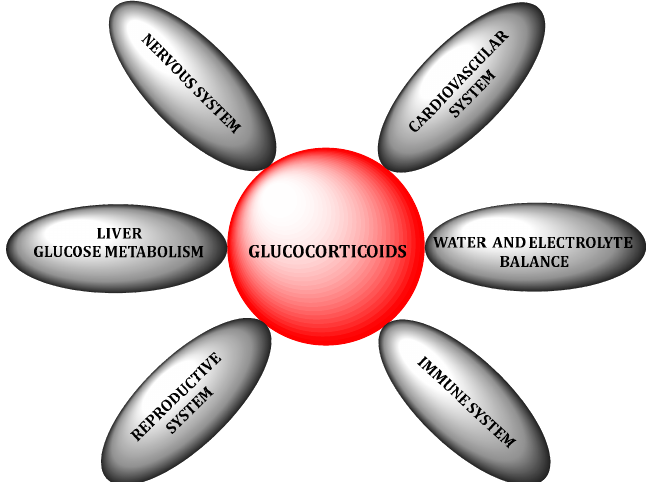
Figure 1. Role of glucocorticoids in physiological processes.